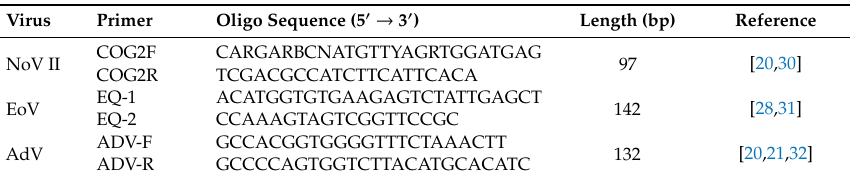
Table 3. Qualitative PCR primer set a .